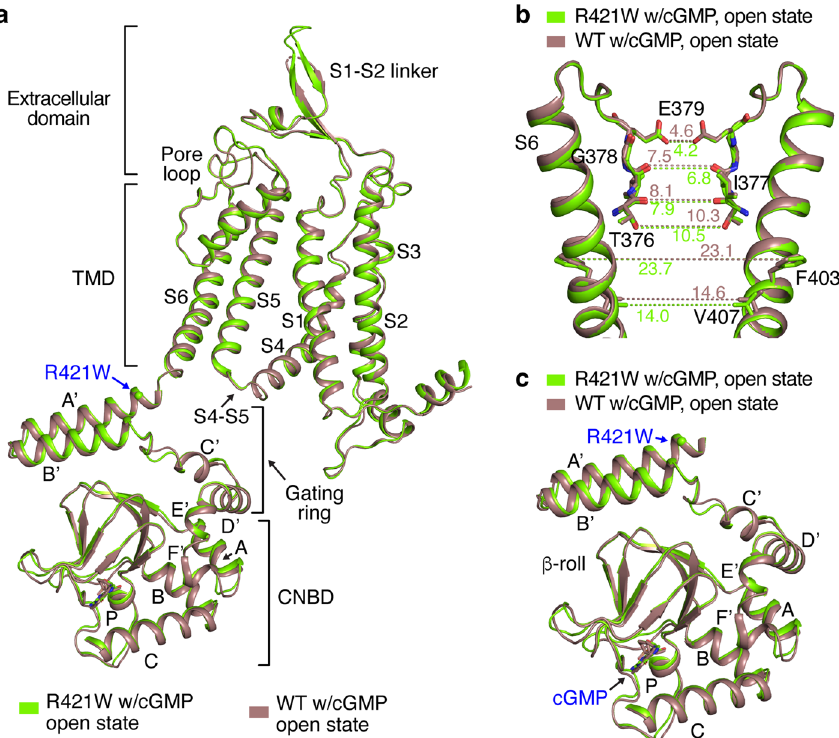
Fig. 2 Structure of cGMP-bound TAX-4_R421W. a Superposition of protomer structures of cGMP-bound WT (PDB ID: 6WEK) and mutant TAX-4. b Comparison of the SF (formed by T376, I377, G378 and E379) and central cavity (below the SF). Distances between two diagonally opposed subunits are indicated. c Comparison of the CNBD and